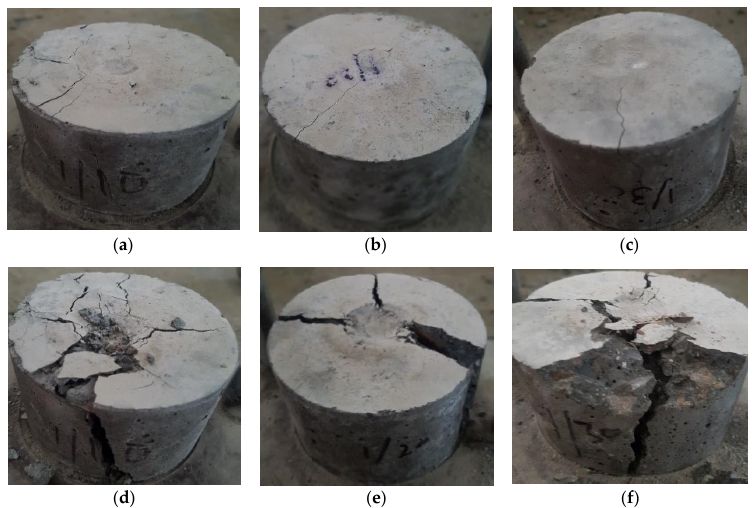
Figure 16. Control specimen under impact loading: ( a ) initial crack, ( b ) final crack.